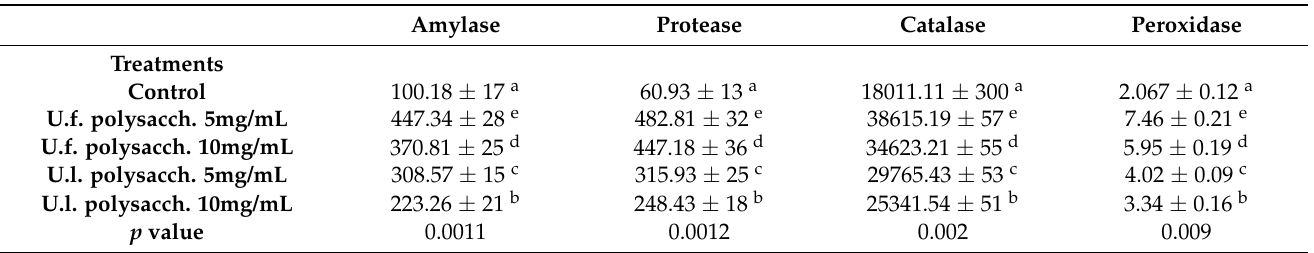
Table 4. Effects of seed priming with different concentrations of soluble polysaccharides on the enzyme activities of growing seedlings of Zea mays seeds at the end of the germination period (5 days).